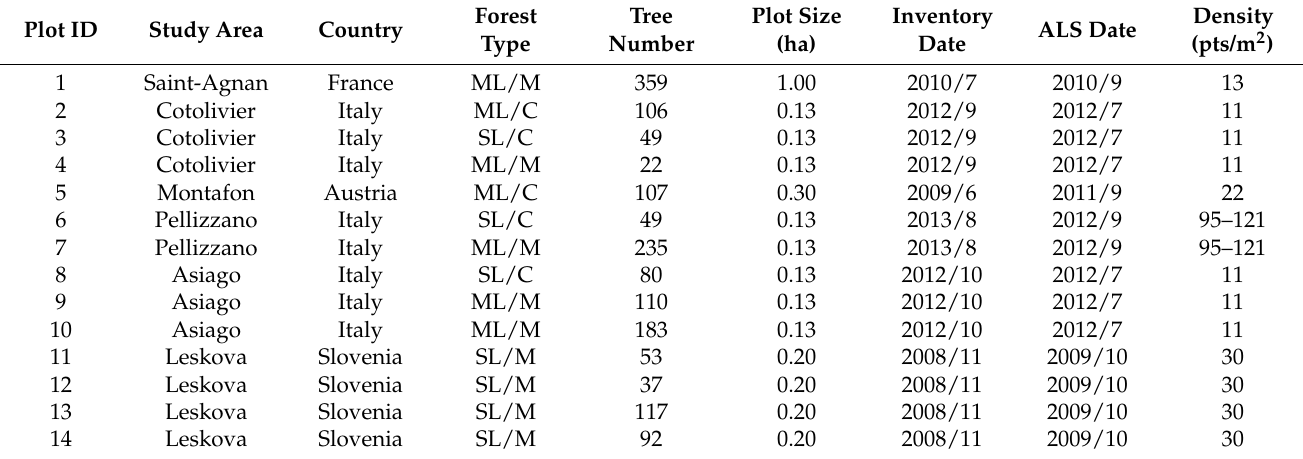
Table 1. Ground inventory details of the